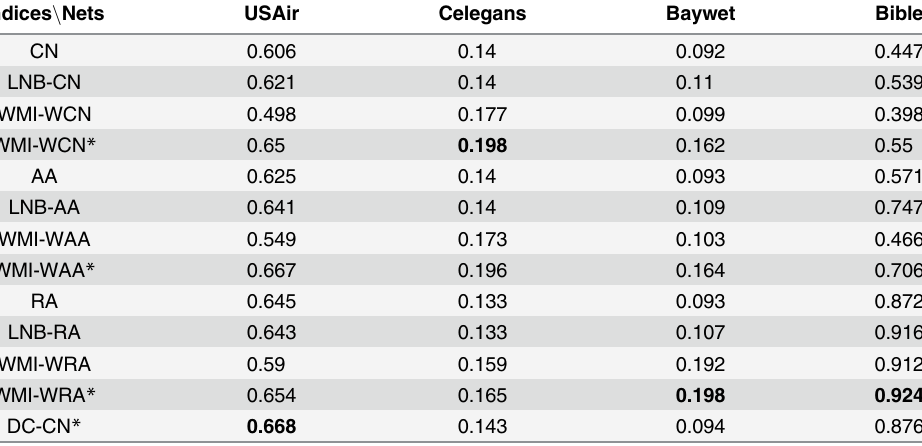
Table 1. Comparison of WMI-based methods with other typical unweighted indices measured by Pre- cision (top-100) on four networks. Each value is obtained by averaging over 100 independent runs of ran- dom division of training set and probe set. The abbreviations WMI-WCN * , WMI-WAA * and WMI-WRA * represent highest Precision values obtained by Eqs (19) – (21), respectively. The optimal values of α are pre- sented in Table 2. The best performance in each network is marked by bold